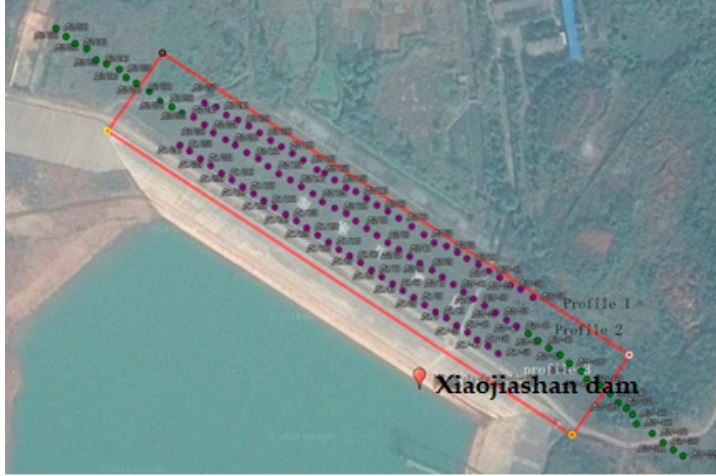
Figure 3. Pseudo-3D arrays for Xiaojiashan Dam leakage detection.